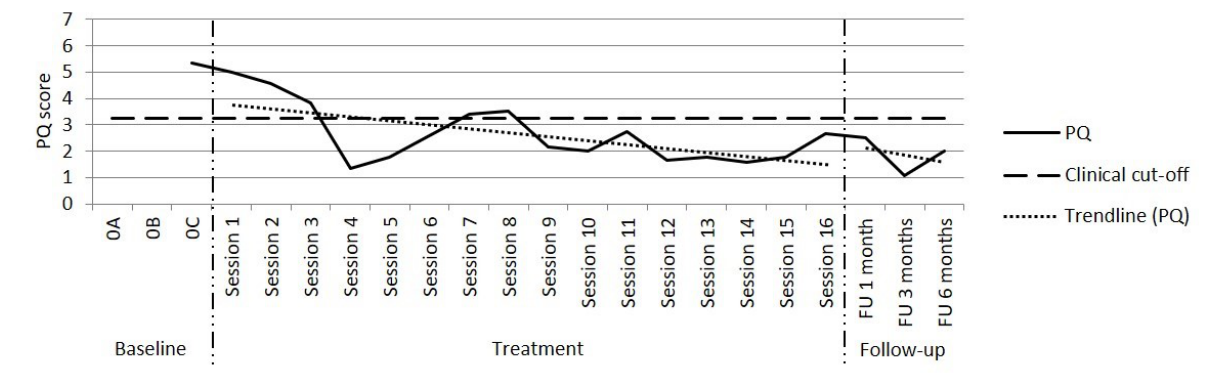
Note . The first available score was in assessment session 0C. 0A, 0B and 0C = assessment sessions. FU = follow-up. PQ =